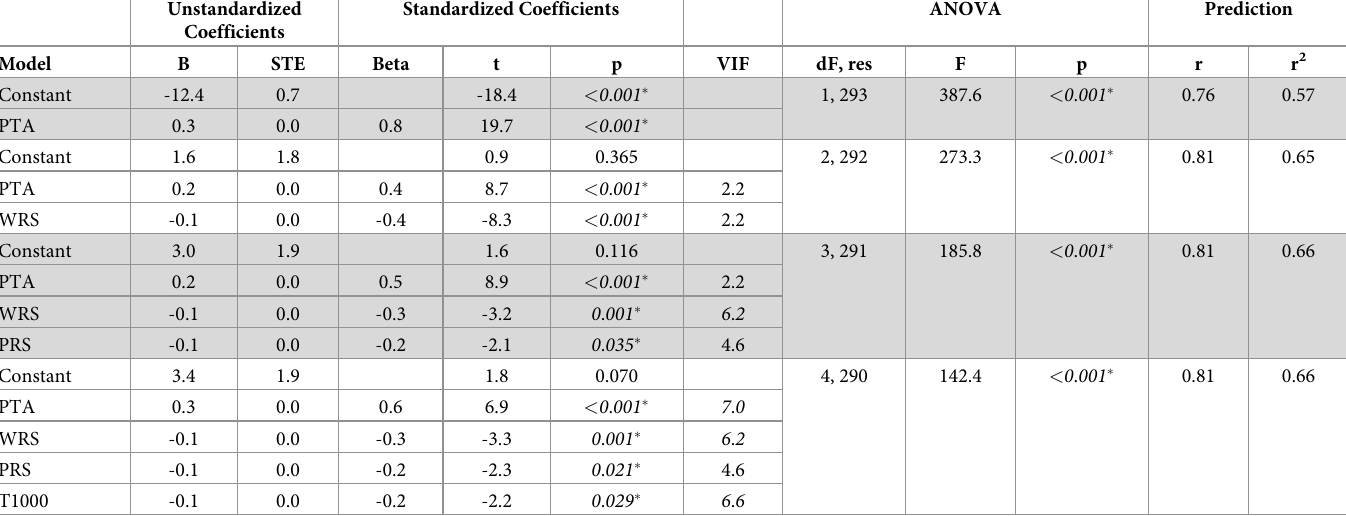
Table 4. Results from forward stepwise linear regression model. SRT in diffuse noise was the dependent variable. The four predictors in the model were pure-tone aver- age (PTA) threshold in the better ear, word recognition scores (WRS) in quiet, phoneme recognition scores (PRS) in quiet, and thresholds in the better ear at 1000 Hz. Coefficients of the model are shown at left, the results from the analysis of variance (ANOVA) are shown in the middle, and the prediction (r and r 2 ) are shown at right. The asterisks indicate significant effects for the coefficients and the ANOVA results. For the value-inflated factor (VIF) column, the italicized values indicate substantial collinearity among the entered predictors in the model (VIF >